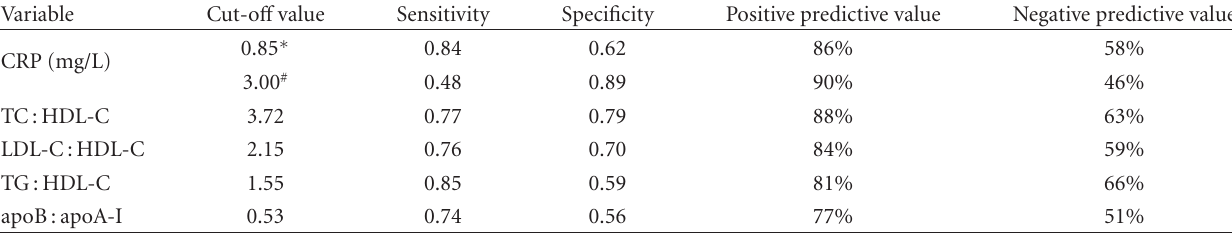
Table 6: Diagnostic usefulness of the assayed parameters for the occurrence of